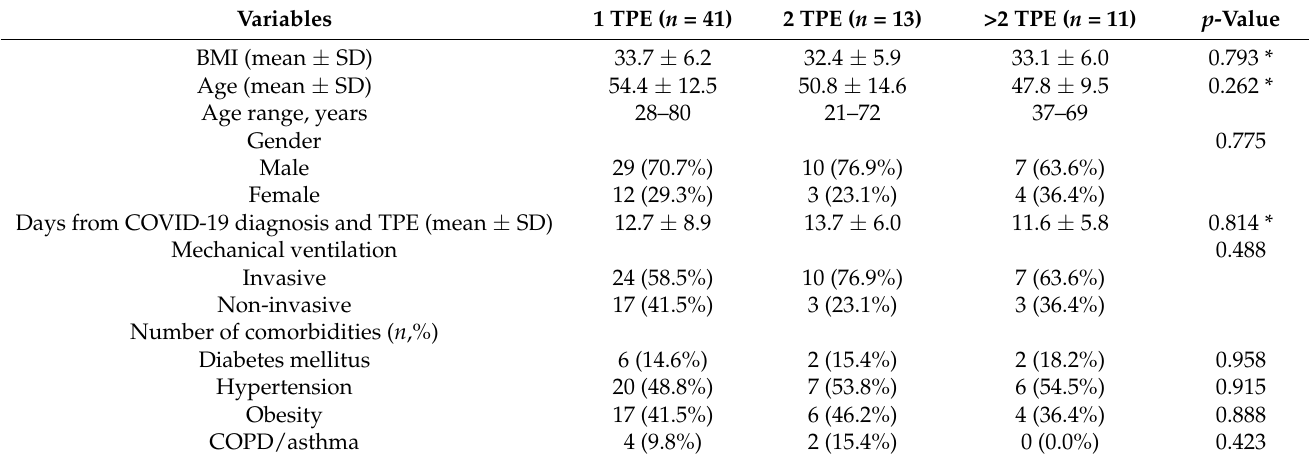
Table 1. Comparison of baseline characteristics of patients with severe COVID-19 by number of TPE sessions.